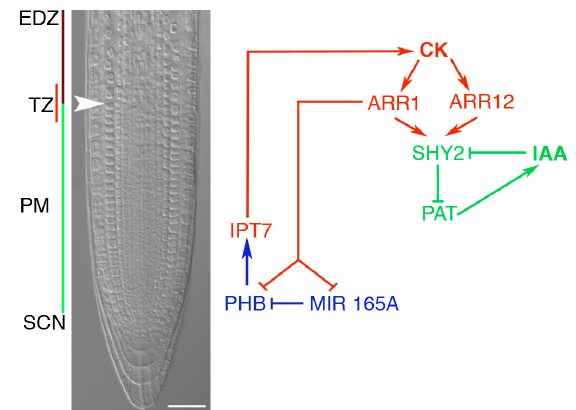
Figure 3. Interplay between the HD-Zip III protein PHB and CKs in the regulation of root meristem size. DIC image of the Arabidopsis root tip with different developmental zones indicated, stem cell niche (SCN), proximal meristem (PM), transition zone (TZ), and elongation and differentiation zone (EDZ), together with a schematic representation of the molecular interactions involved in the determination of RAM size. PHB induces CK biosynthesis in the PM of the root; cytokinin is delivered to the